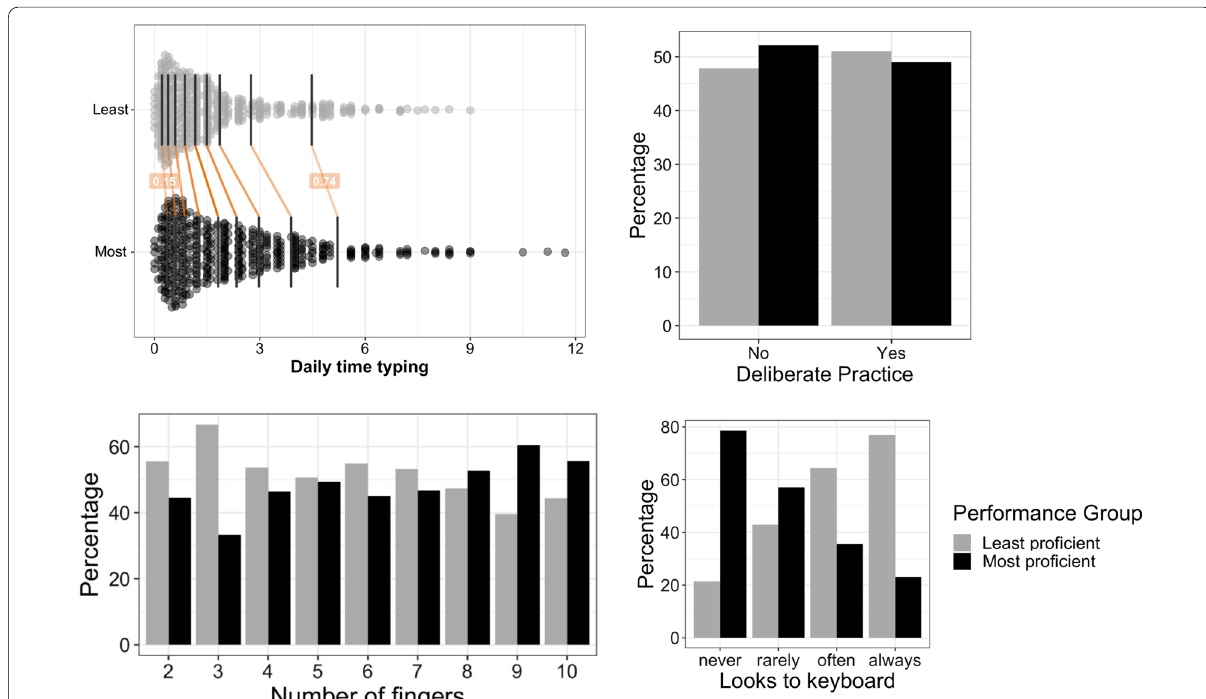
Fig. 5 Typing habits according to performance groups. From top to bottom and left to right: daily time spent typing, deliberate practice, number of fingers used for typing, frequency of looks to the keyboard while typing. For the bar graphs, the percentage of most and least proficient typists within each level of the factor of interest is